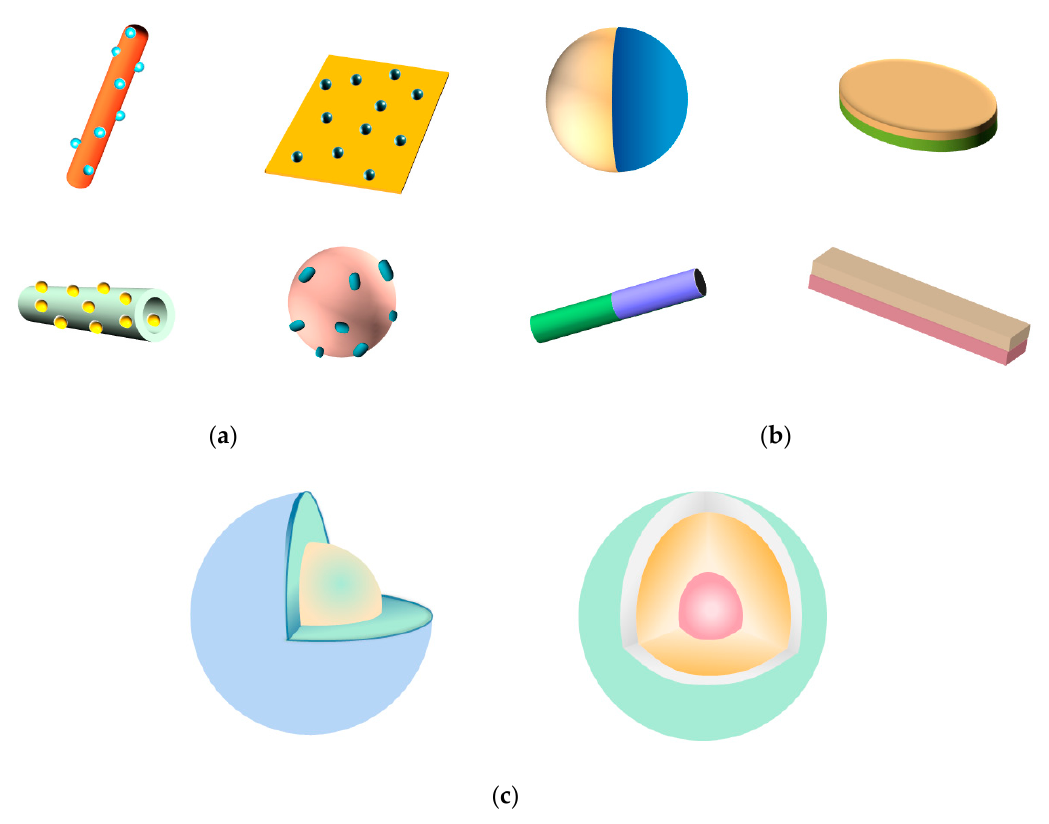
Figure 2. The schematic diagram of ( a ) surface decorated structure; ( b ) Janus structure; and ( c ) core-shell structure.